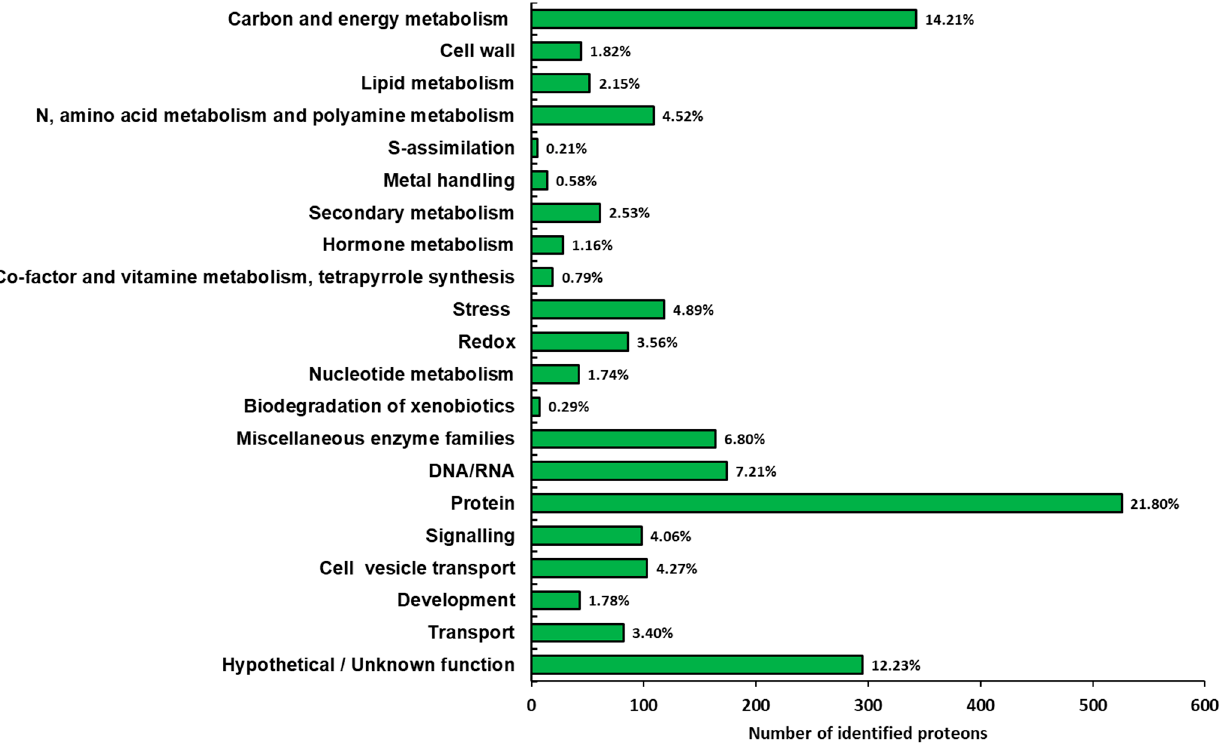
Figure 4. Functional distribution of the identified proteins in ginseng. The identified proteins were classified into metabolic functional classes according to the BIN ontology.